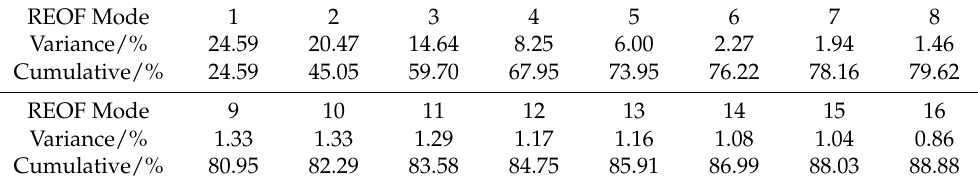
Table 1. Variance contribution rate and cumulative variance contribution rate of each REOF